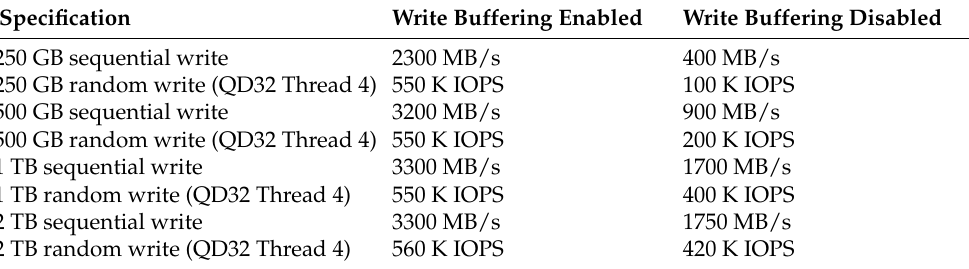
Table 1. Write performance in Samsung SSD 970 EVO Plus 250 GB